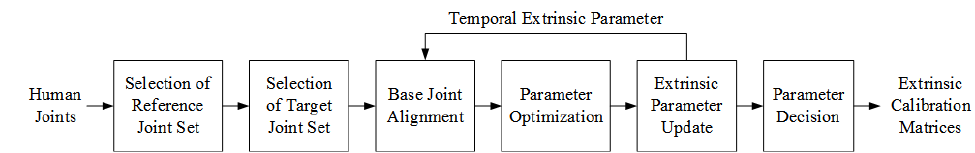
Figure 4. Proposed joint-based extrinsic